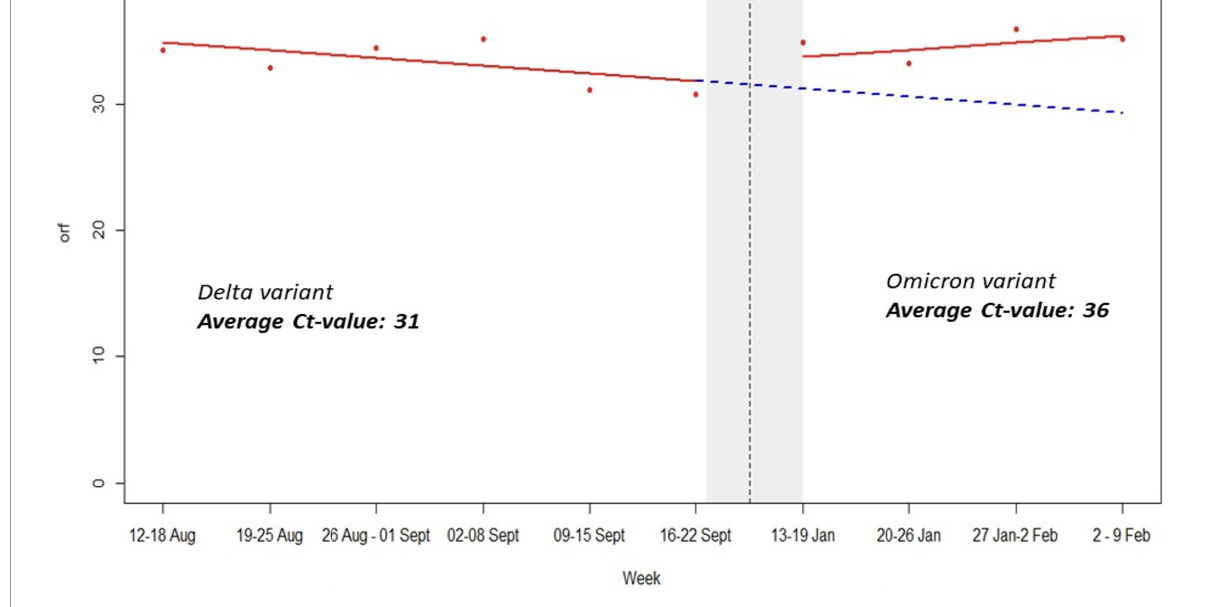
FIGURE4 Impact of variants C t -values on dogs’